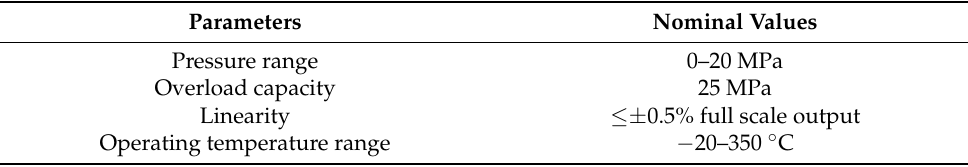
Table 2. Specification of the 6113B pressure